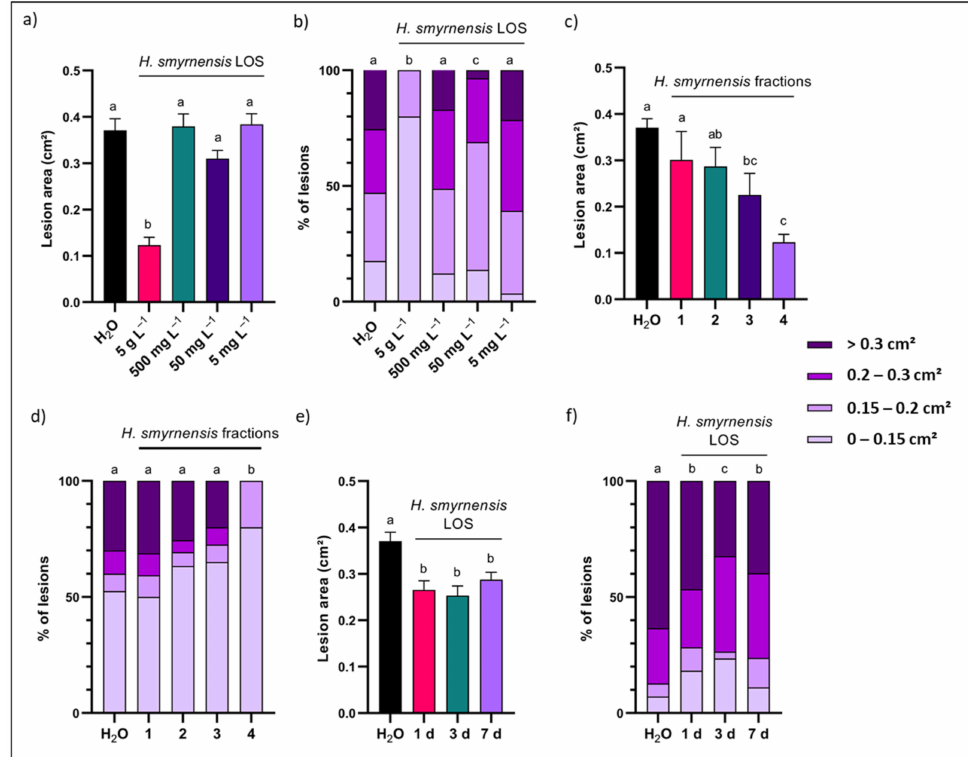
Figure 5. Influence of concentration, degree of polymerization (DP) and priming duration of fruc- tans in the rocket- Botrytis cinerea pathosystem. After 72 h of priming (unless denoted otherwise), leaves were detached, rinsed and inoculated with B. cinerea spores. Infection progressed for 72 h before disease scoring. ( a ) Average lesion area of leaves sprayed with different concentrations of Halomonas smyrnensis levan oligosaccharides (LOS). ( b ) Percentage of lesions belonging to four dif- ferent classes based on lesion size after priming with different concentrations of LOS. ( c ) Average lesion area for different levan fractions produced from H. smyrnensis levan degradation. Fraction 4 resembles the LOS fraction. ( d ) Percentage of lesions belonging to each lesion size class for different H. smyrnensis fractions. ( e ) Average lesion areas of rocket leaves infected at different time points after LOS priming. Bars represent the mean ± SEM. ( f ) Percentage of lesions belonging to four different classes based on lesion size, with B. cinerea spore inoculation at different time points after priming. Fructans were sprayed at a concentration of 5 g L − 1 unless specified. At least 30 biological replicates were used for each treatment and the experiments repeated three times with consistent results.